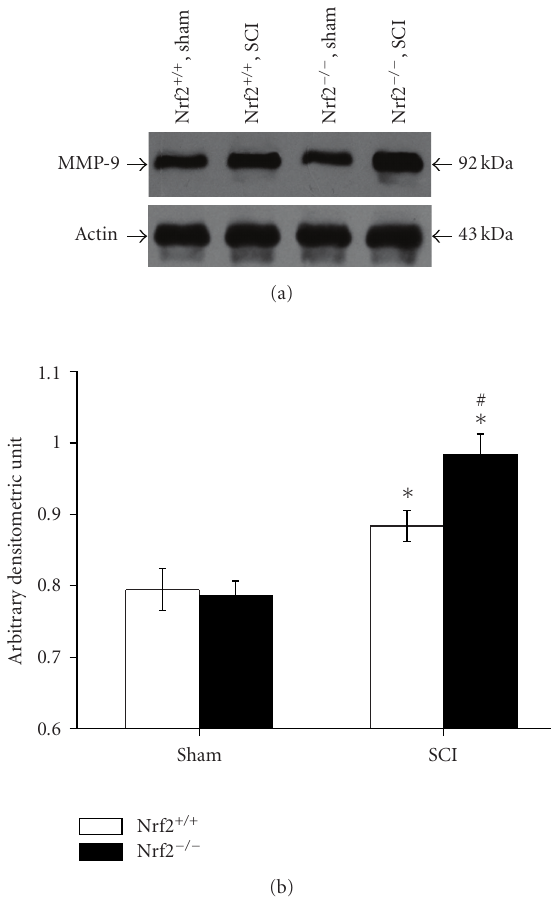
Figure 6: MMP-9 expression by Western blot analysis in spinal cord homogenates from sham and injured Nrf2 (+/+) and Nrf2 ( − / − ) mice. (a) Representative X-ray film shows MMP-9 expression by Western blot analysis at 24 hours after SCI in sham and injured Nrf2 (+/+) and Nrf2 ( − / − ) mice. (b) The figure indicates that higher MMP-9 expression levels were found in Nrf2 ( − / − ) mice than in Nrf2 (+/+) mice at 24 hours after SCI. Bars represent mean ± S.E. ( n = 6, each group). ∗ P < . 01 versus sham control of the same genotype. # P < . 01 versus injured wild-type